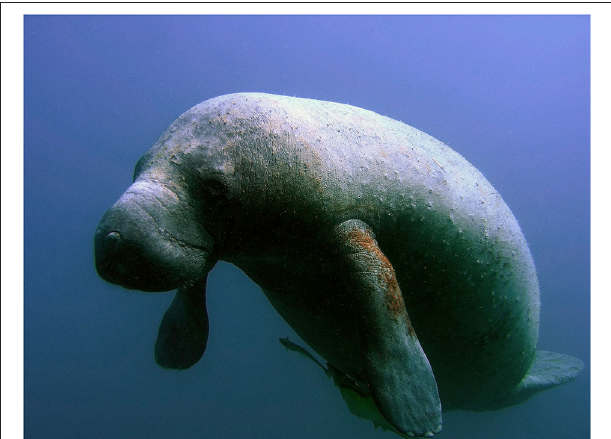
FIGURE 1 | Manatee ( Trichechus manatus , sometimes referred to as “seacow”)—a herbivore that was reclassified in 2017, under the authority of the ESA, from “endangered” to “threatened” when total manatee population estimates jumped from a few thousand in 1991 to over 8,000 to 13,000 in subsequent years [U.S. Fish and Wildlife Service (FWS), 2017]. Yet, protections of this marine mammal do not significantly change because habitat fragmentation and loss, noise pollution and other disturbances, and vessel strikes remain as threats. Original image provided by the National Oceanic and Atmospheric Administration (NOAA) (used with